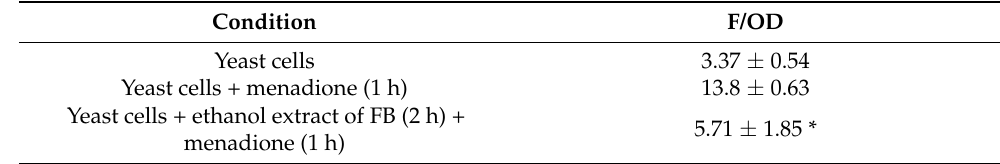
Table 3. Determination of lipid peroxidation. Data represent mean values of F/OD ± SD. Asterisk (*) indicates a statistically significant difference between yeast cells treated with FB extract followed by menadione and cells treated only with menadione ( p < 0.05). Condition F/OD Yeast